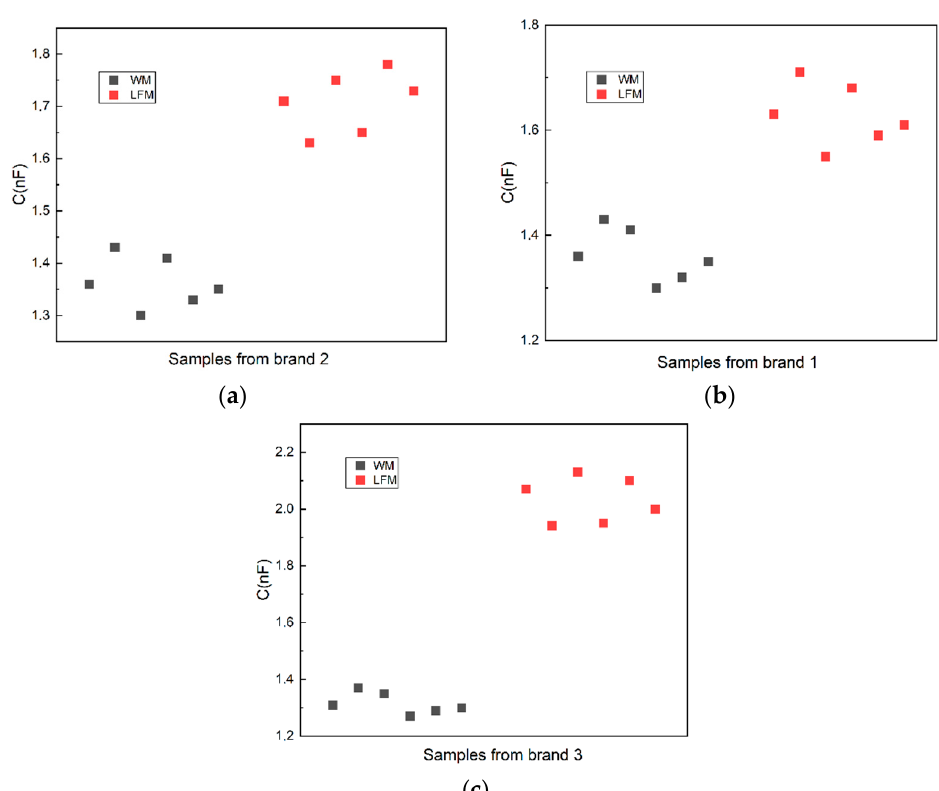
Figure 8. Comparison of capacitance values to distinguish whole milk from lactose-free milk for different brands (samples from brand 2 ( a ); from brand 1 ( b ) and from brand 3 ( c )).